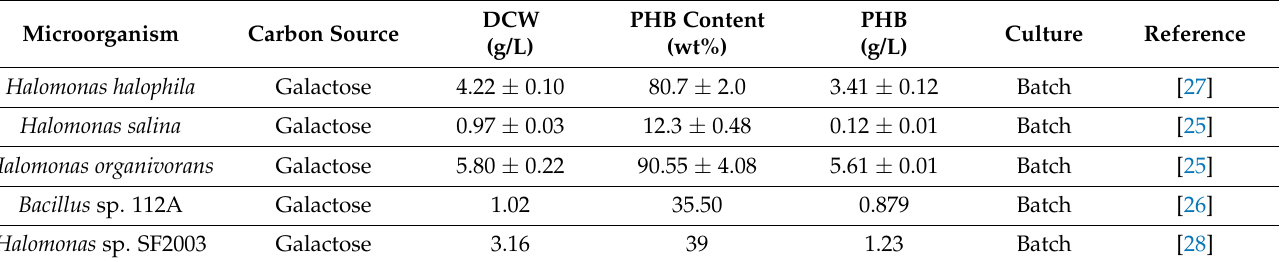
Table 1. PHA synthesis using